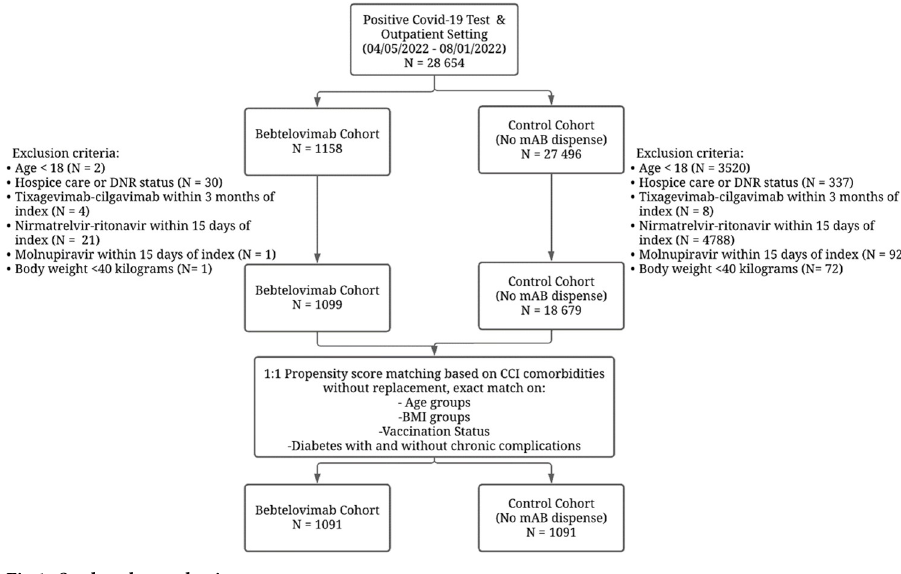
Fig 1. Study cohort